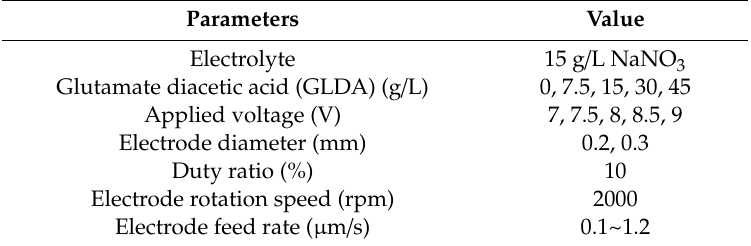
Table 1. Experimental conditions for wire electrochemical micromachining (WECMM) .